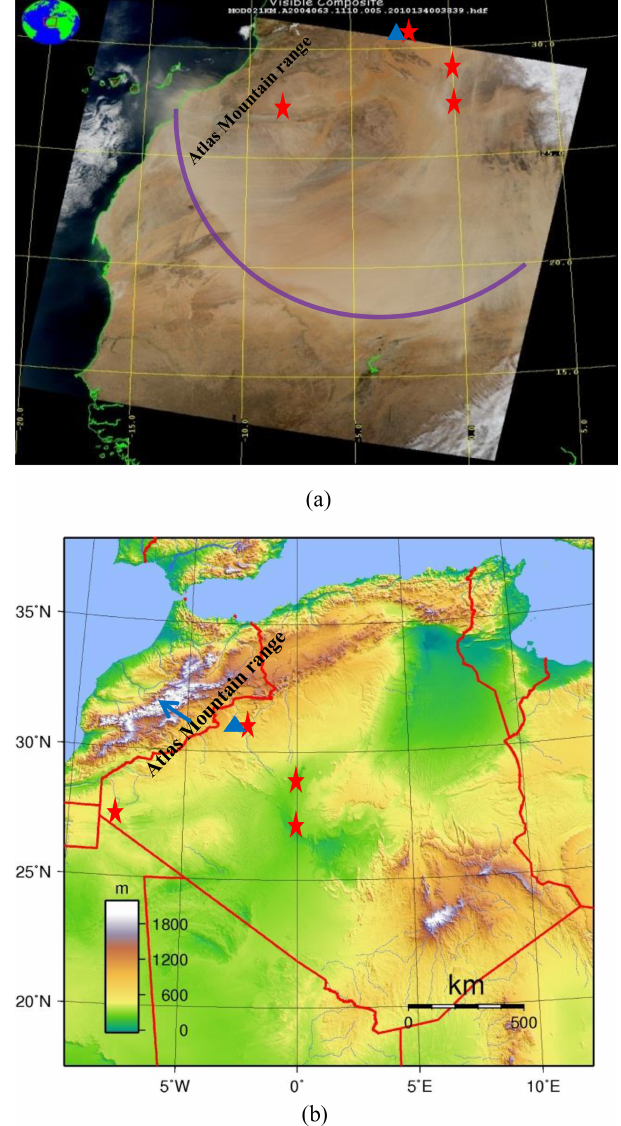
Figure 2. (a) Dust storm image captured by MODIS AQUA at 11:10UTC on 3 March 2004 (source: https://ladsweb.nascom. nasa.gov). The purple colored arc depicts the outline of the arc of dust plume. The red stars indicate surface stations (Bechar, Tindouf, Timimoun, and Adrar) in Algeria of which x and y coordinates are mentioned in Sect. 3.1.1 (Harmat- tan dust storm case study), which captured the dust storms on 2 March 2004 (source: https://www.wunderground.com/, last ac- cess: 26 May 2016; Pokharel et al., 2017b). The blue triangle in- dicates the soundings station at Bechar in Algeria. (b) Topograph- ical map of Algeria (http://www.carte-algerie.com/carte-algerie/ carte-topographique-algerie.jpg, last access: 12 October 2019) in which the red star indicates surface stations (Bechar, Tindouf, Tim- imoun, and Adrar), which experienced the dust storms on 2 March 2004 (source: https://www.wunderground.com/). The blue colored triangle indicates the soundings station at Bechar in Algeria.